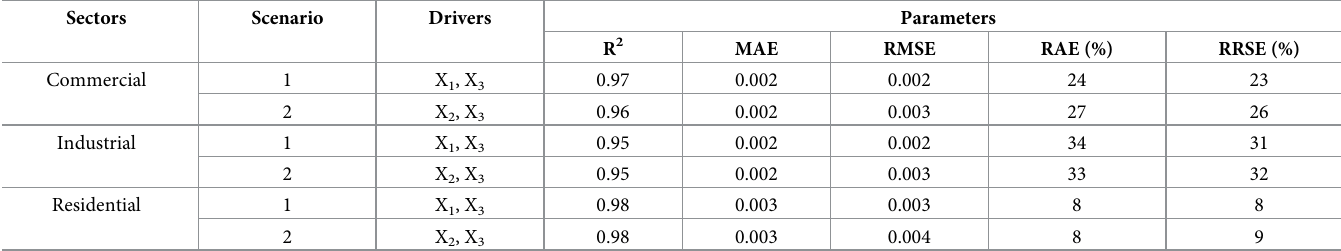
Table 5. Evaluation of drivers for water consumption prediction.